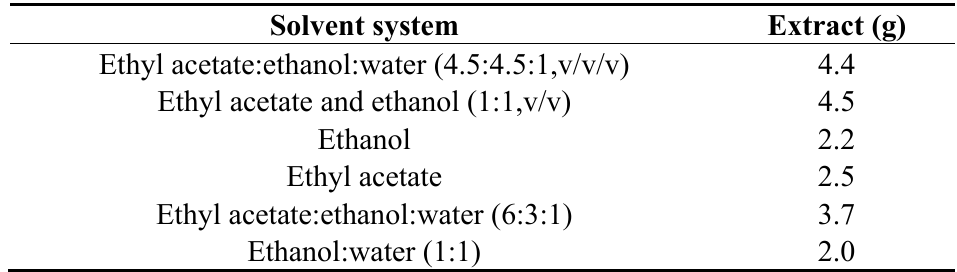
Table 1. Total extract from 20 g white birch